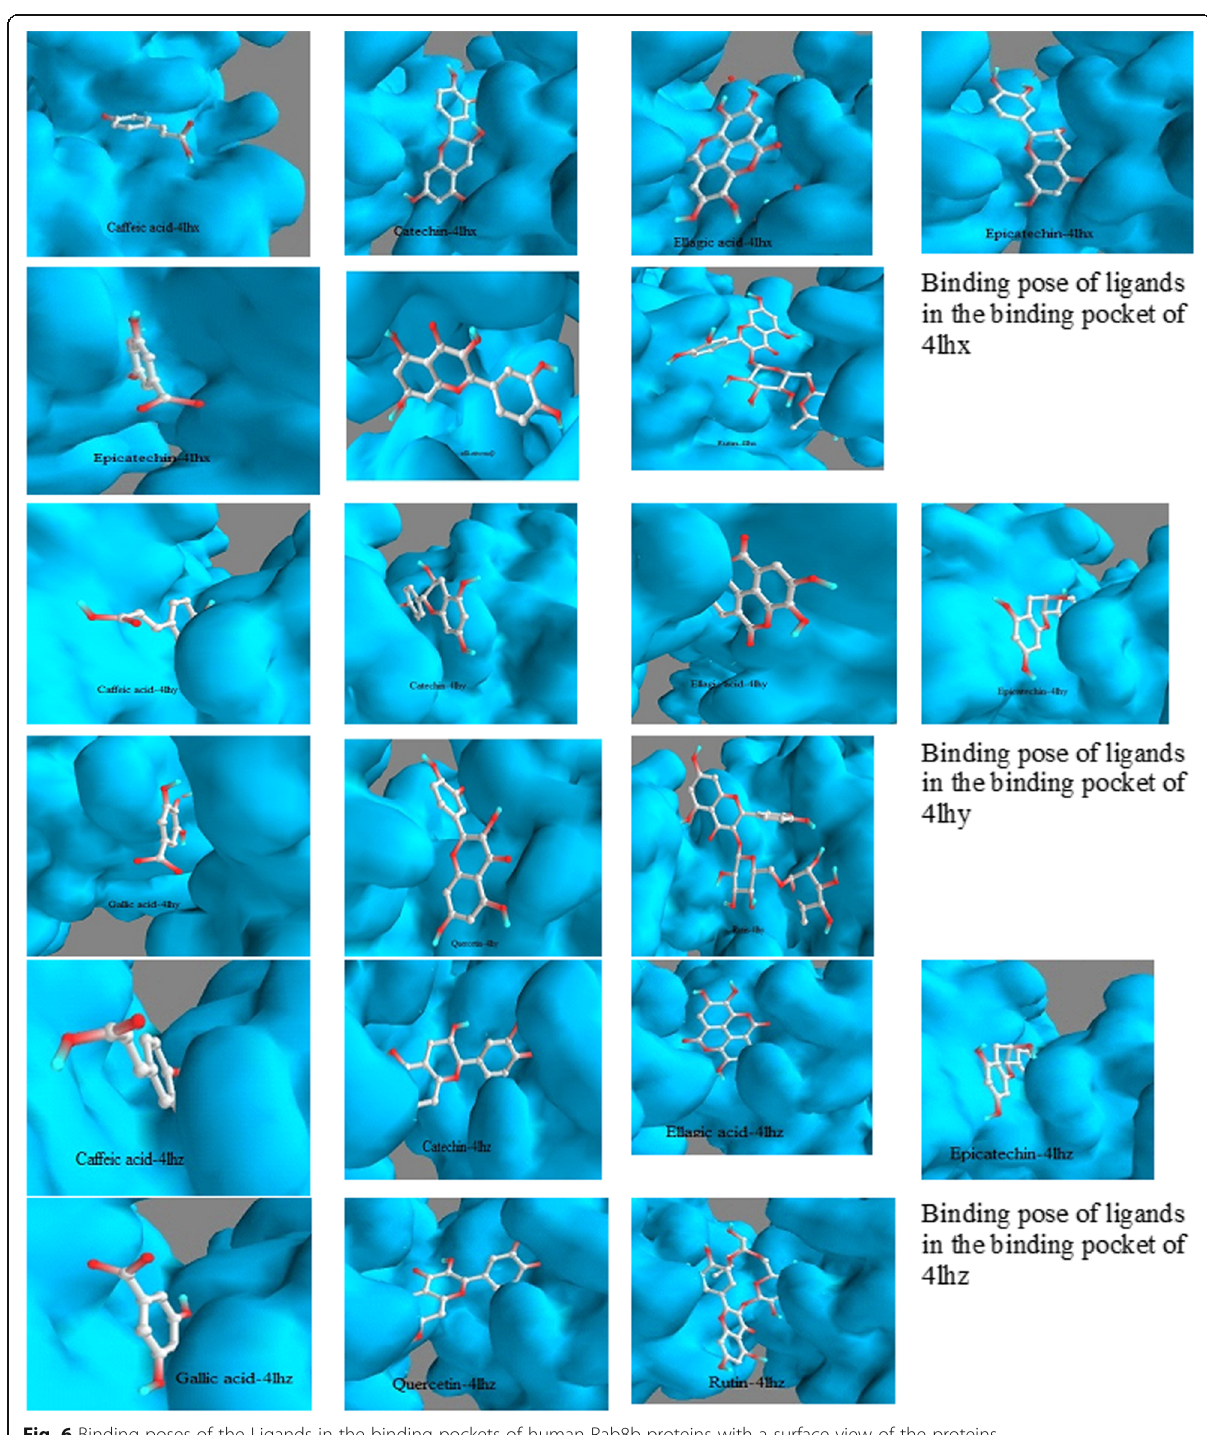
Fig. 6 Binding poses of the Ligands in the binding pockets of human Rab8b proteins with a surface view of the